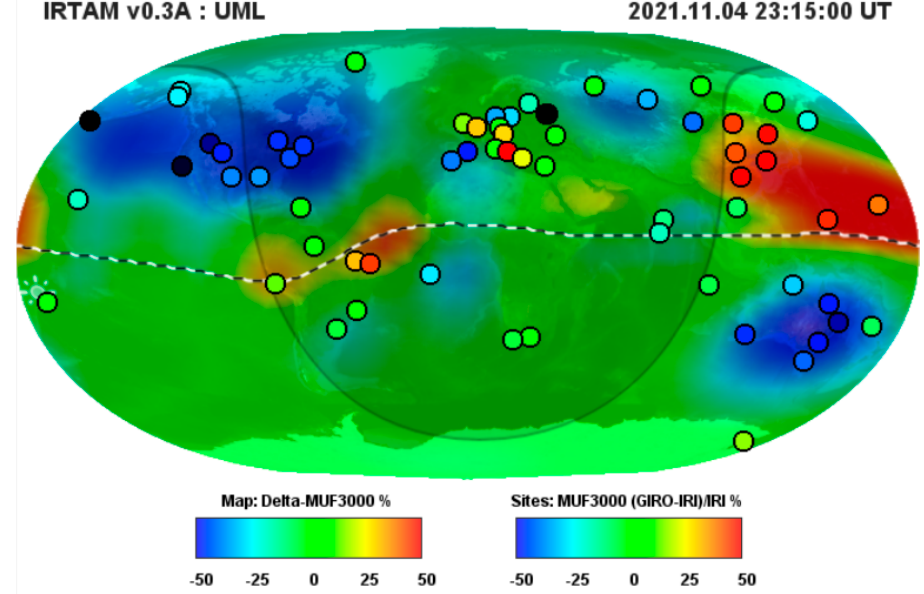
Figure 1. GIRO weather nowcast showing a severe ~50% depression of the Maximum Usable Frequency (MUF) (blue shades) during a negative phase of the 4 − 7 November 2021 G3 − category storm. Color dots: local deviations of MUF from the quiet ‐ time International Reference Ionosphere (IRI) model as observed by 67 GIRO ionosondes. Color surface: global MUF anomaly map computed by GIRO ‐ IRI data fusion algorithm NECTAR. The dashed line is the magnetic equator, and the shaded area corresponds to nighttime.